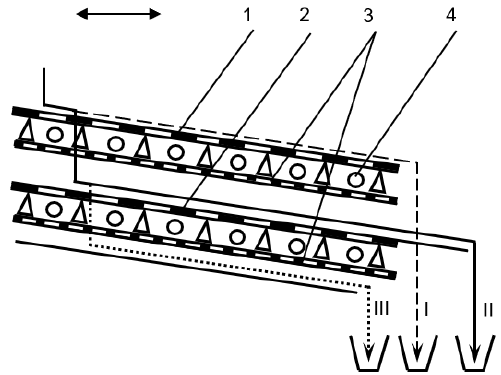
Figure 2. Design and technological scheme of arrangement of sorting sieves and ball cleaners. 1 — sorting sieve; 2—lower sorting sieve;3—reflective rod surfaces of ball cleaners; 4—rubber balls; top sorting sieve;2 — lower sorting sieve;3 — reflective rod surfaces of ball cleaners; 4 — rub- I—large fraction, II—medium fraction; III—small ber balls; I — large fraction, II — medium fraction; III — small fraction.